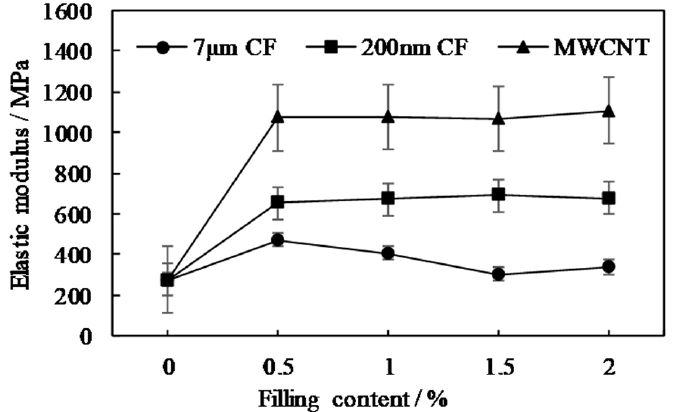
Figure 10. Elastic modulus of micro/nano CF and MWCNT modified PTFE composites.